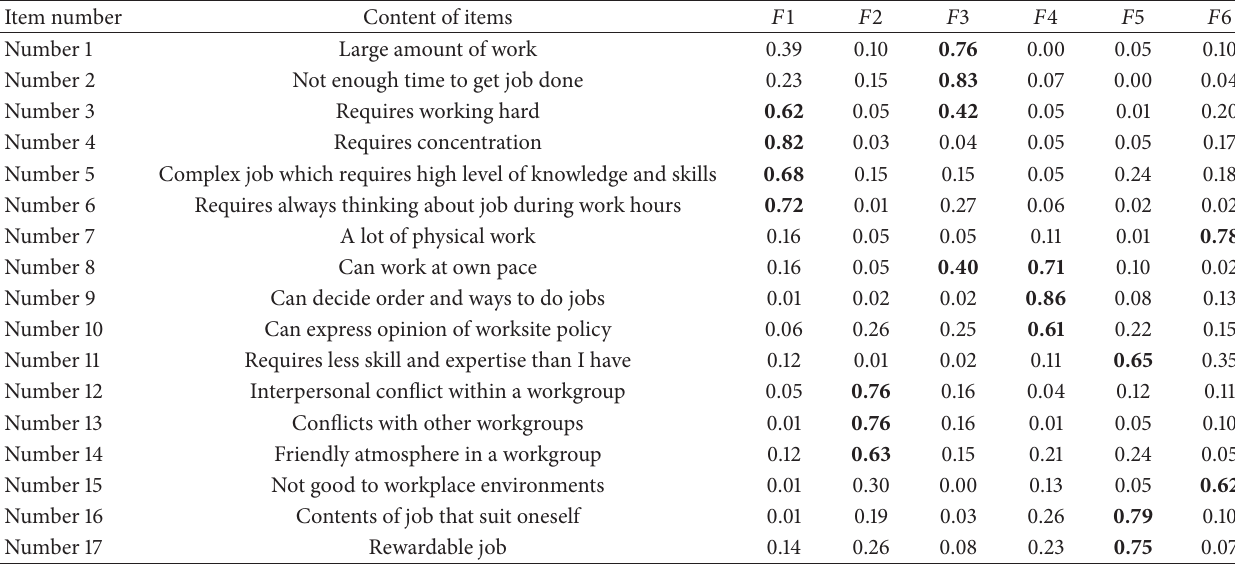
Table 1: Job stress factors structures in the previous study.